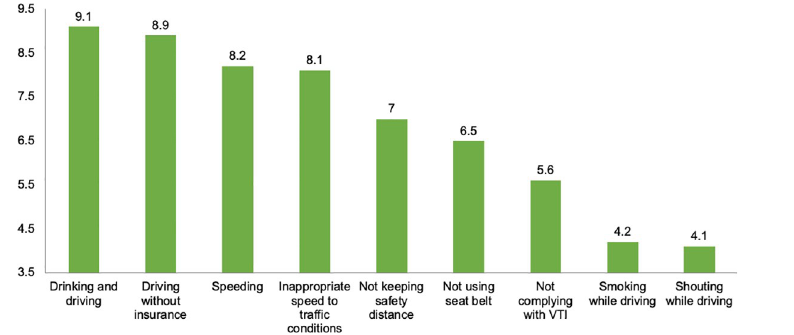
Fig 5. Perceived punishability of different driving misbehaviors.